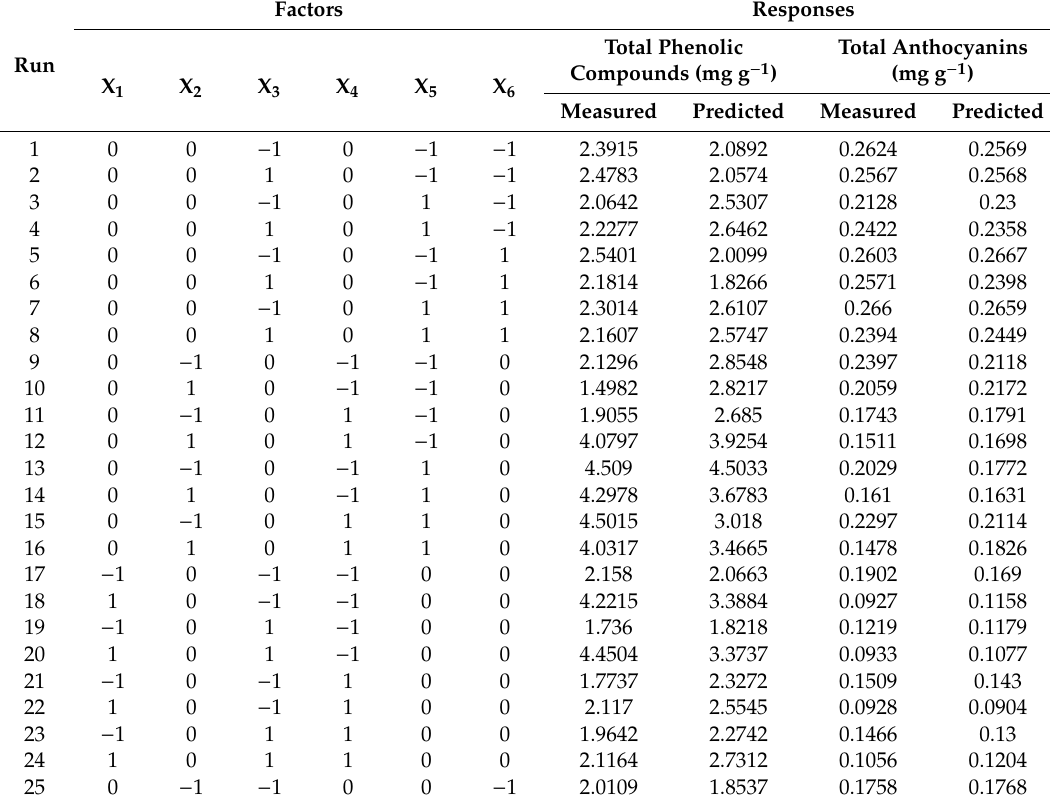
Table 1. Box–Behnken design matrix with measured and predicted